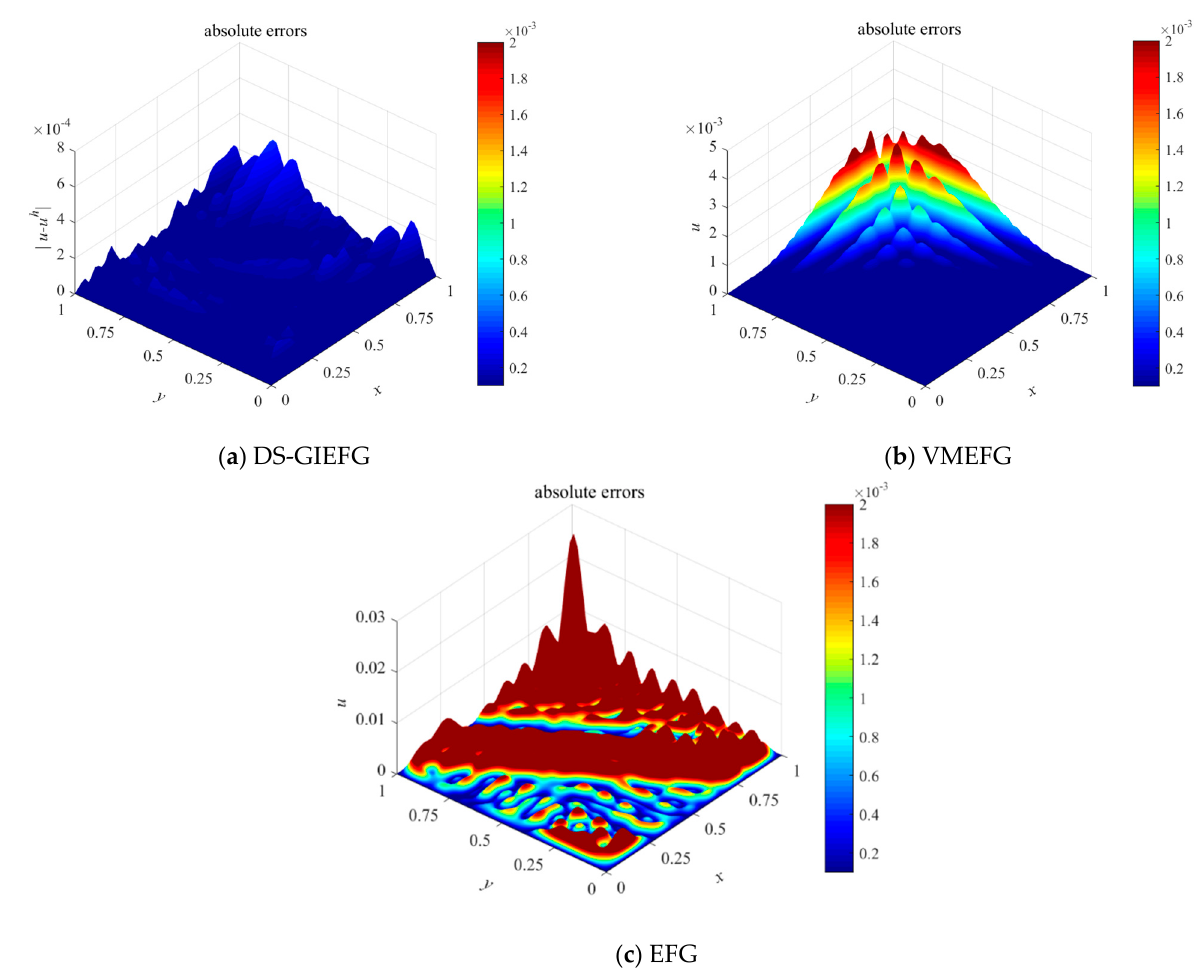
Figure 3. Absolute errors of the solutions solved by the ( a ) DS-GIEFG method, ( b ) VMEFG method and ( c ) EFG method